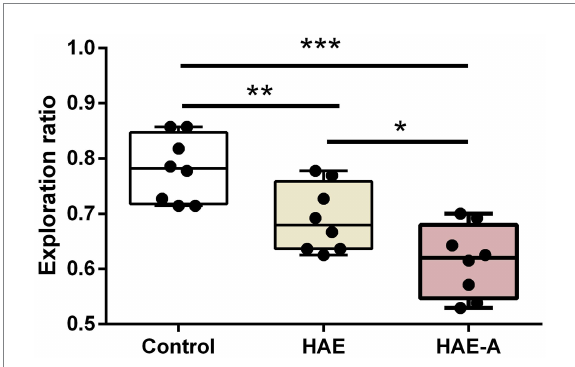
FIGURE 2 Effects of high altitude and antibiotics on exploration ratio by novel object test. Data are presented with the means ± standard deviation ( n = 8). *Difference is significant at the 0.05 level ( p < 0.05); **difference is significant at the 0.01 level ( p < 0.01); ***difference is significant at the 0.001 level ( p <